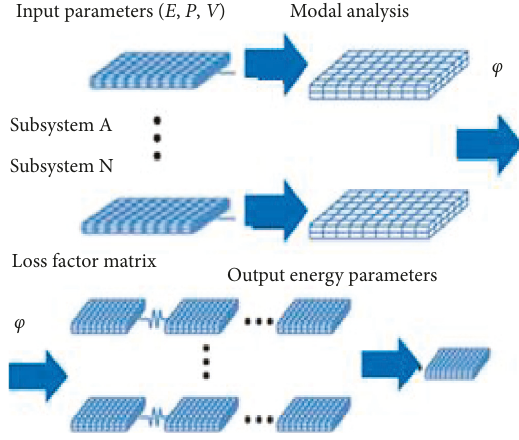
Figure 14: SMEDA method calculation